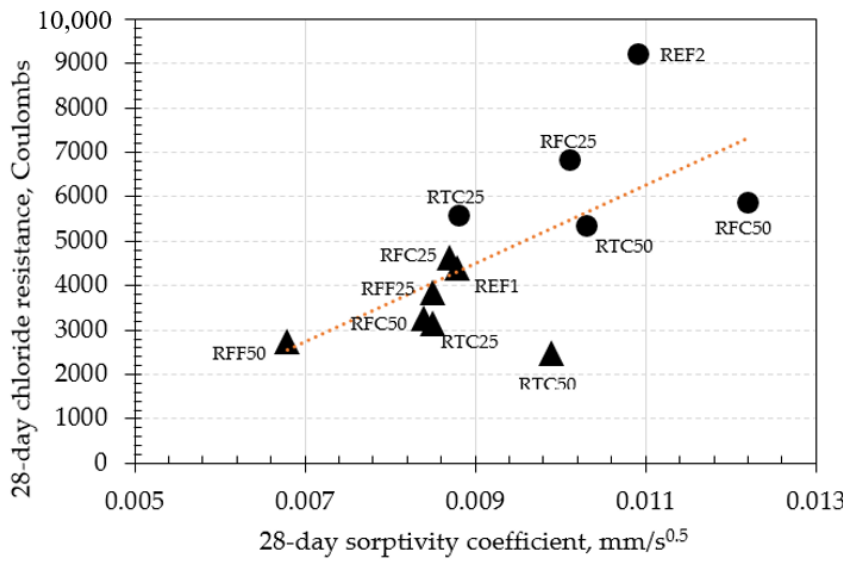
Figure 10. Relationship between rapid chloride penetration resistance and capillary water absorption of concretes at 28 days ( ▲ = w/c ratio 0.25; ● = w/c ratio 0.5).